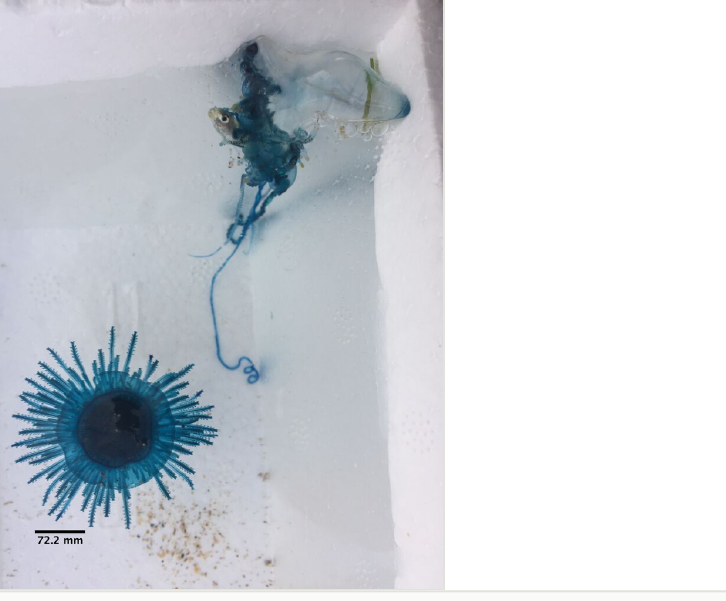
Figure 8. Stranded Physalia physalis (top) and Porpita porpita (bottom) in Semawang Beach, Denpasar City, Bali Island.